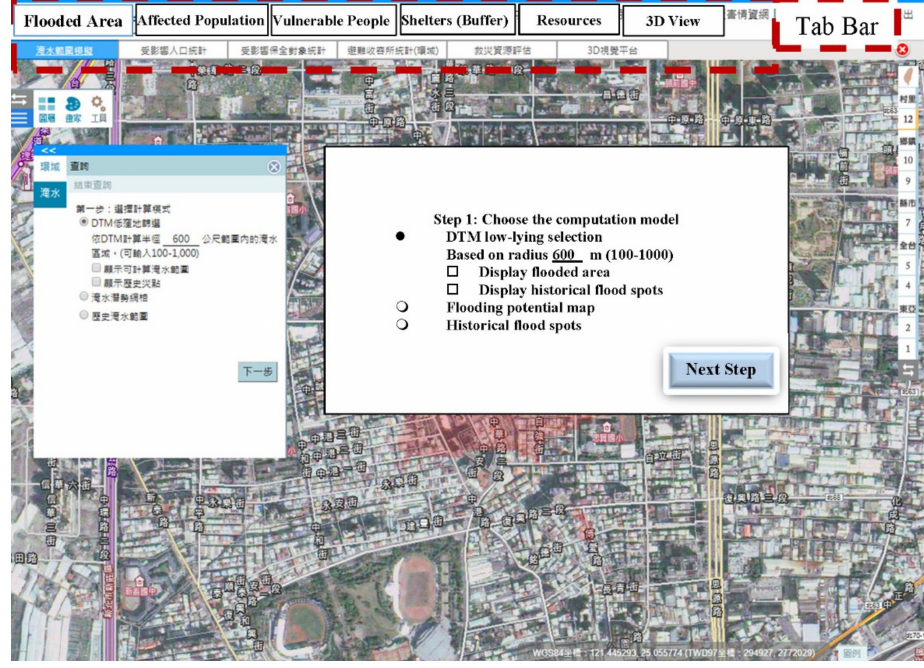
Figure 1. Function tabs in the FWGAP. Tab 1: Calculation of the flooded